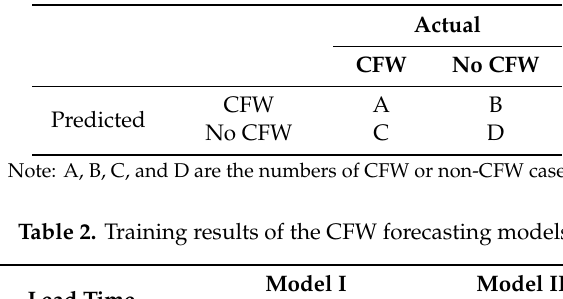
Table 1. Example confusion matrix for coastal freak wave (CFW) forecasting results.